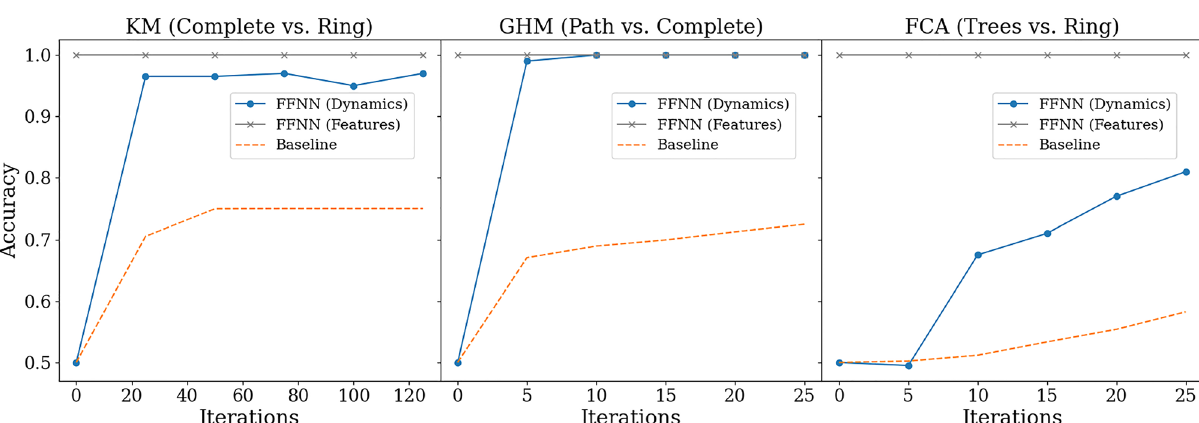
Figure 2. Examples of synchronizing and non-synchronizing dynamics of Kuramoto, Greenberg-Hastings, and FCA oscillators on 30-node graphs with two topologies (complete vs. ring, path vs. complete, and tree vs. ring, respectively). The heat maps show phase dynamics on graphs beneath them, where colors represent phases and time is measured by iterations from bottom-to-top (e.g. t = 0 – t = 70 ). Synchronizing examples have uniform color in the top row. The horizontal bar indicates the ‘training iteration’, which is the maximum number of iterations in the initial dynamics fed into the classification algorithm for prediction.